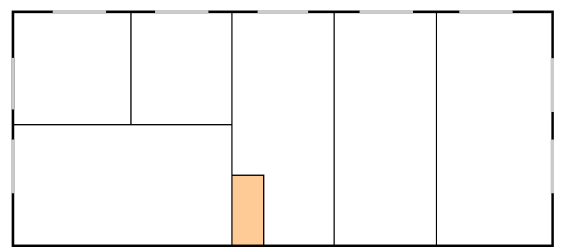
Figure 4: Detection and correction of potential errors in the topo- logical model. The small room omitted from the topological models is estimated using stochastic